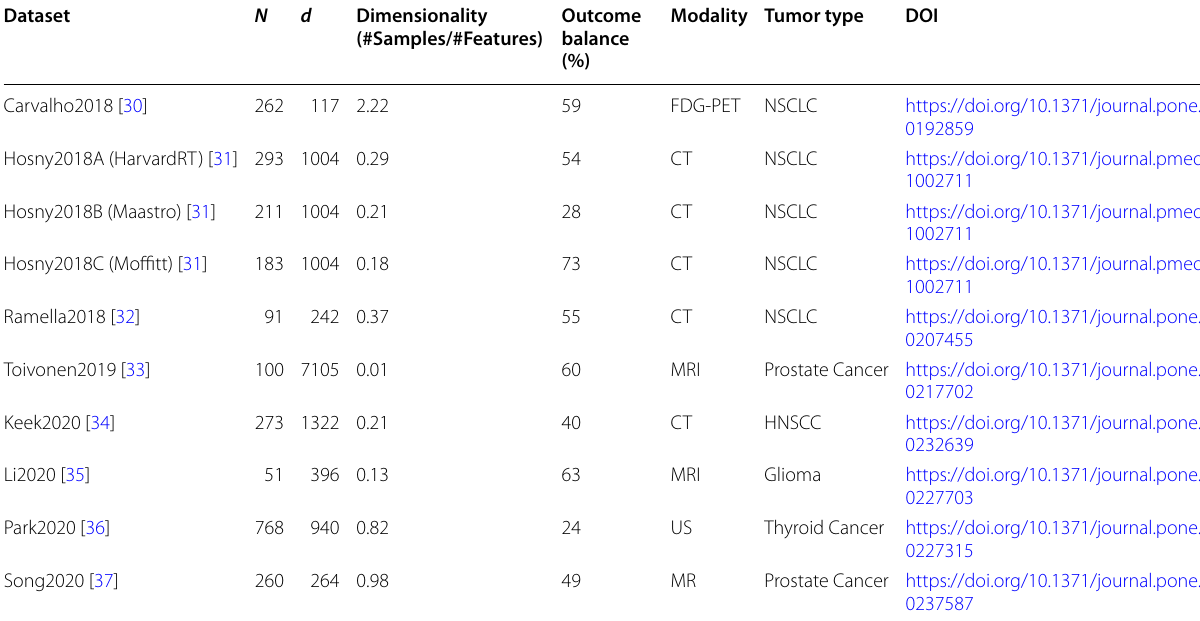
Table 1 Overview of the